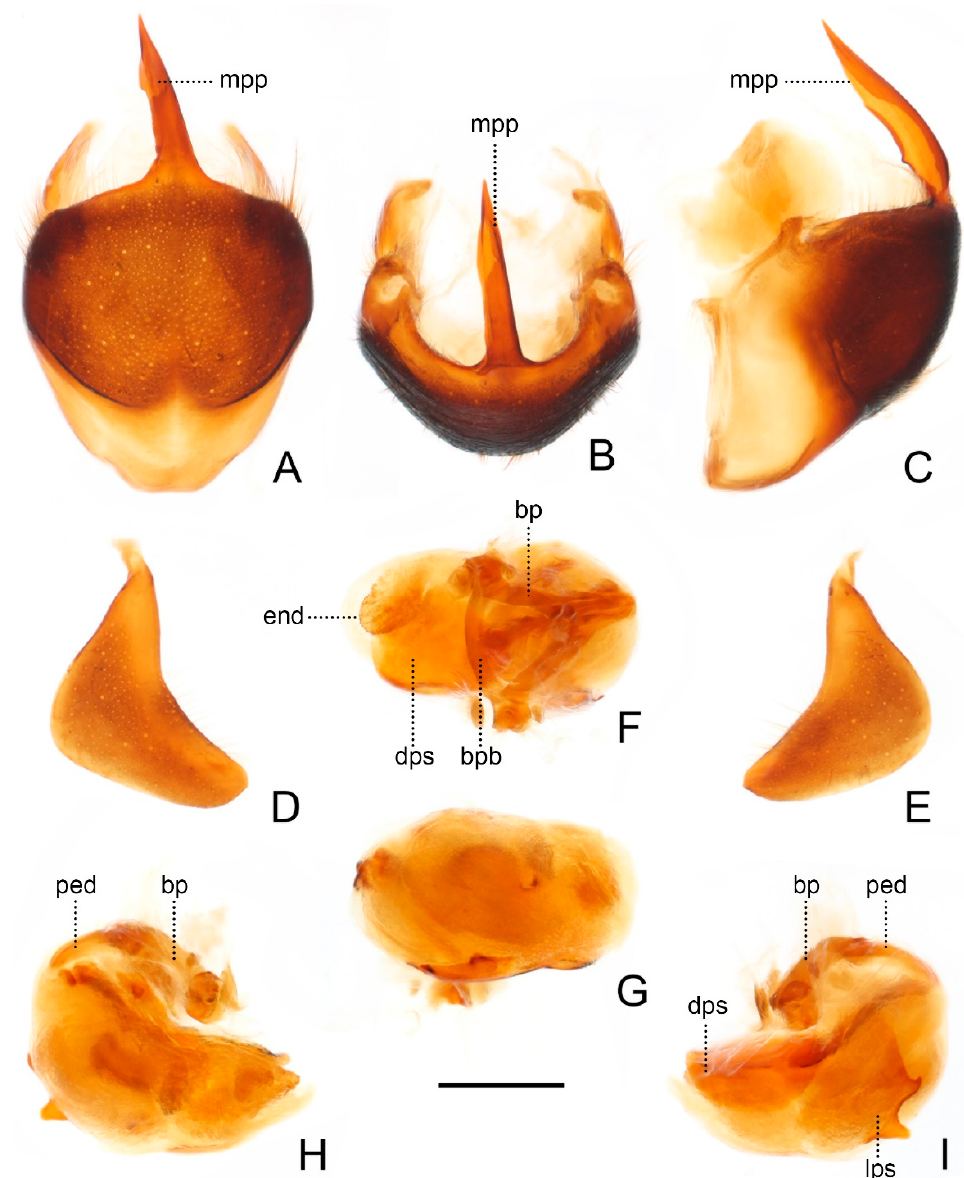
Figure 5. Male genitalia of Sigicoris brumalis comb. nov. ( A ) Pygophore, ventral view; ( B ) ditto, caudal view; ( C ) ditto, lateral view. ( D ) Left paramere, outer ventrolateral view. ( E ) Right paramere, outer ventrolateral view. ( F ) Phallus, dorsal view; ( G ) ditto, ventral view; ( H ) ditto, left lateral view; ( I ) ditto, right lateral view. Scale bar = 0.50 mm. Abbreviations: bp, basal plate; bpb, basal plate bridge; dps, dorsal phallothecal sclerite; end, endosoma; lps, lateral phallothecal sclerite; mpp, median pygophore process; ped, pedicel.